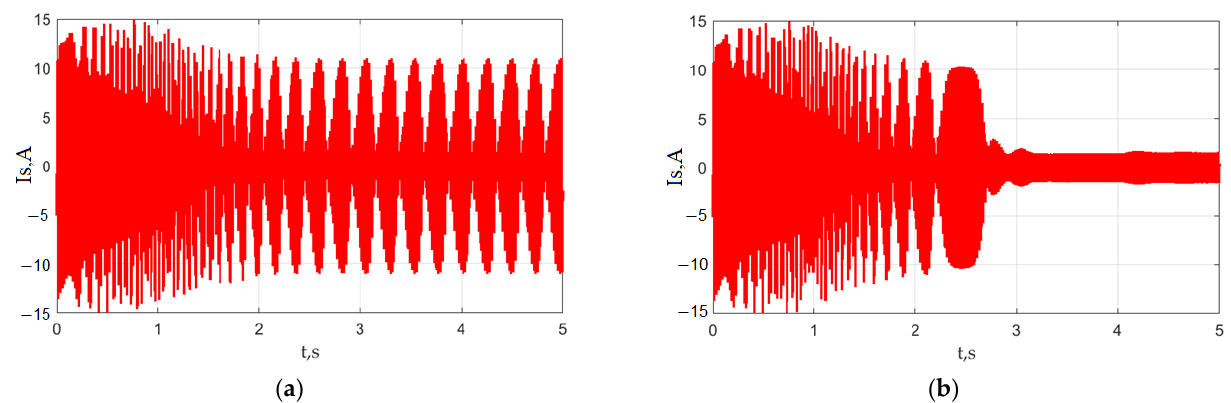
Figure 8. LSPMSM stator current versus time, 380 V: ( a ) Fully open valve; ( b ) fully closed valve.